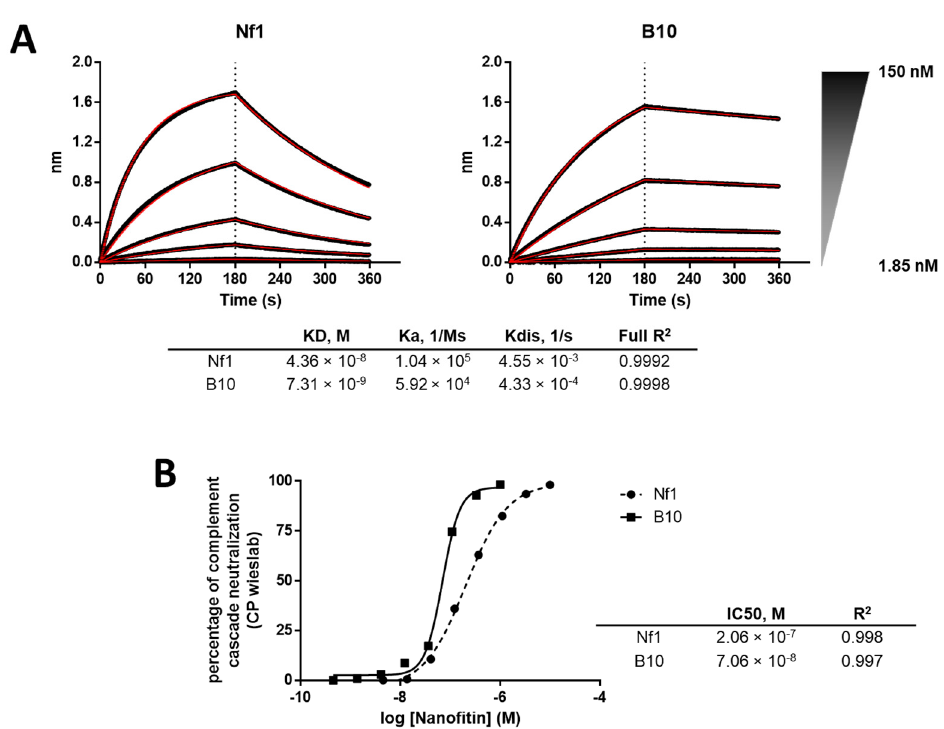
Figure 4. ( A ) Comparison of binding profiles in BLI between Nf1 and the matured B10 variant (i.e., APL-1030) and ( B ) comparison of neutralization potency of Nf1 compared with the matured B10 (n = 1). Table 1. Surface Plasmon Resonance